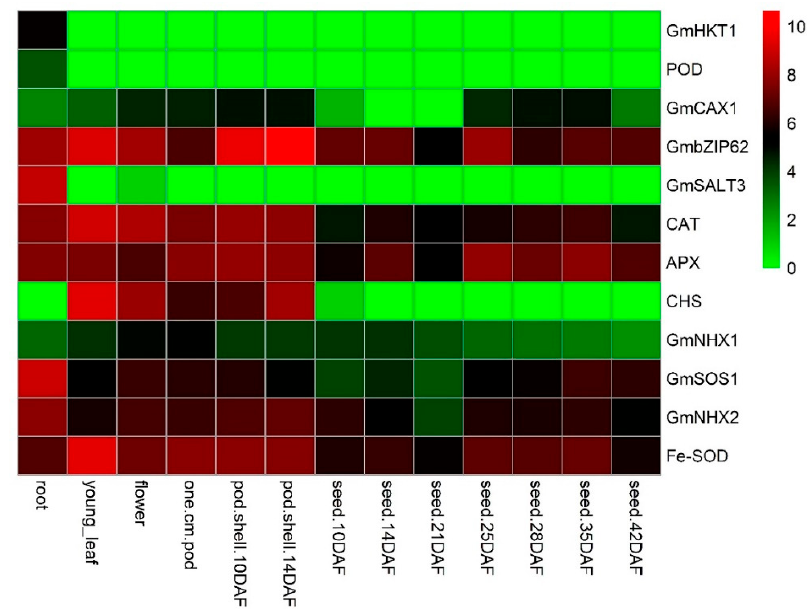
Figure 8. The expressional levels (log2(RPKM + 1)) of antioxidant enzyme-encoding gene and salt-tolerant genes in thirteen soybean tissues.